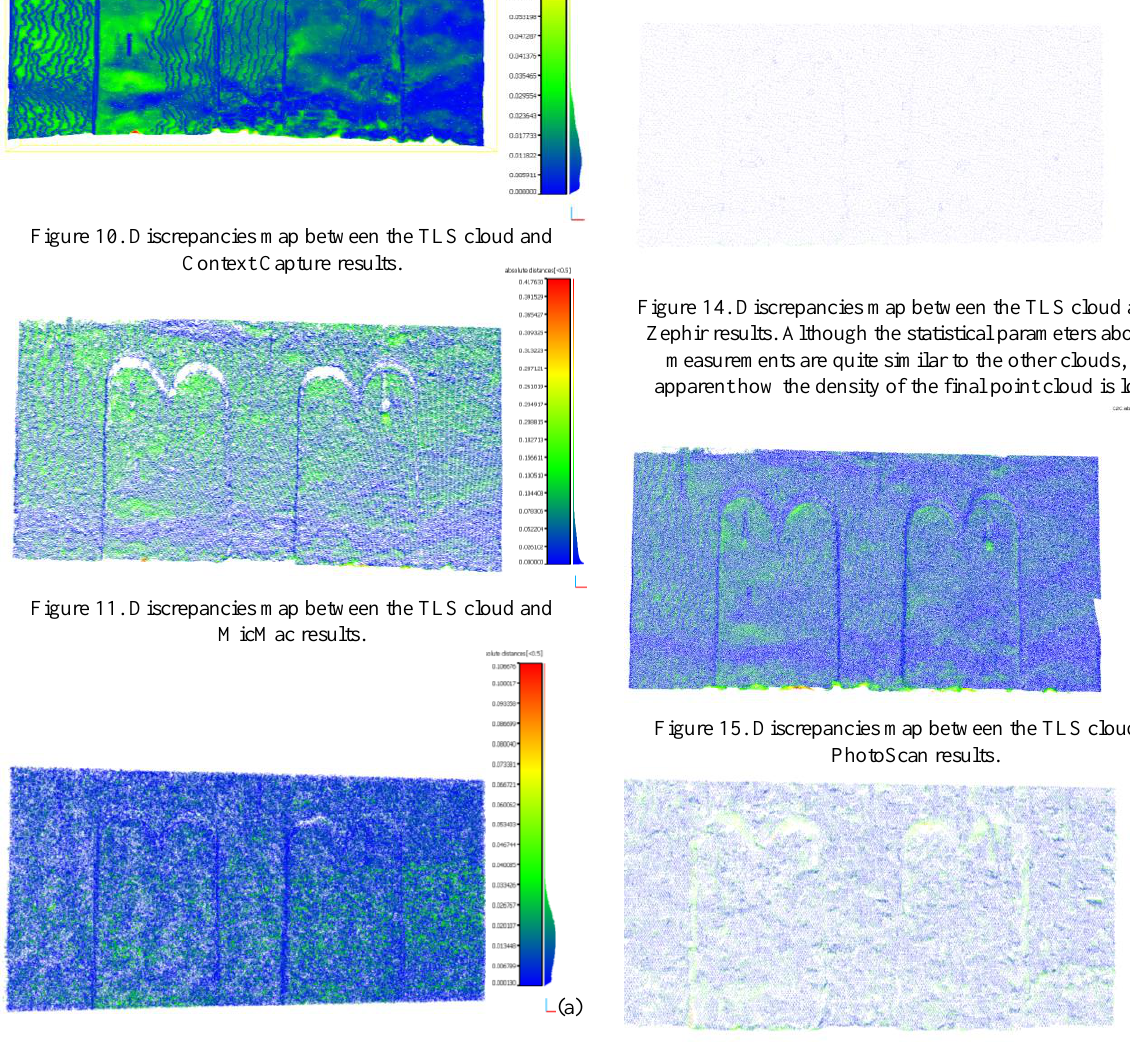
Figure 16. Discrepancies map between the TLS cloud and VisualSFM